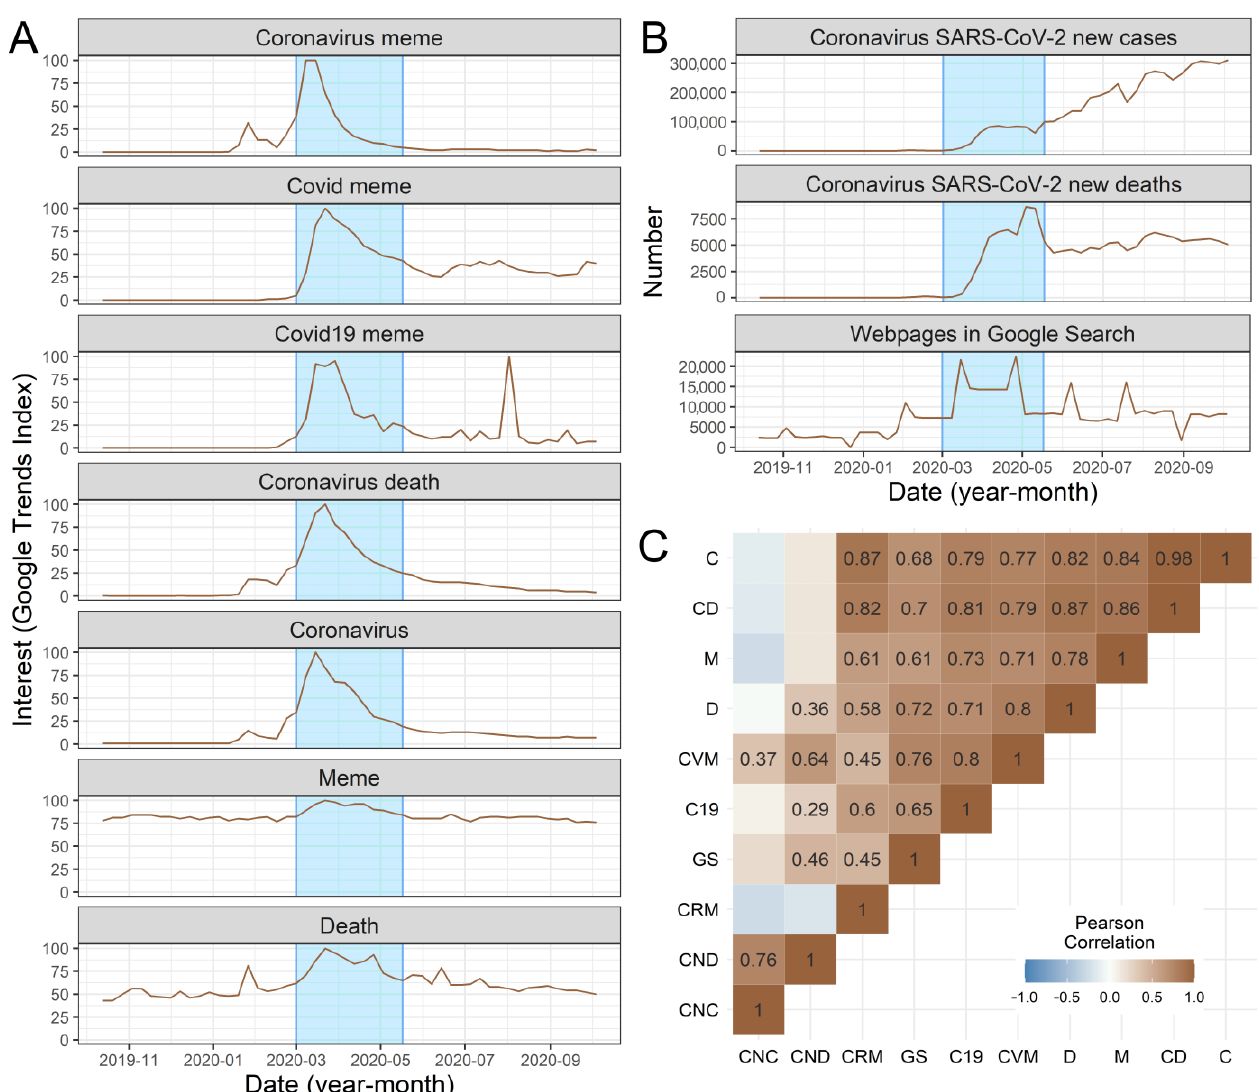
Figure 2. The temporal trends in the selected search strings, coronavirus data, and correlations among analyzed variables. ( A ) The temporal (October 2019 – October 2020) trend in the interest (measured as a Google Trends index) in seven different search strings: “coronavirus meme”, “covid meme”, “covid 19 meme”, “coronavirus death”, “coronavirus”, “meme”, “death”. The blue rectan- gles indicate the period of a spring 2020 lockdown. ( B ) The temporal changes in real numbers of SARS-CoV-2 coronavirus new cases and deaths, and web pages in Google Search containing the phrase: “(coronavirus OR covid 19 OR covid) meme”. ( C ) Correlations among the search strings, real coronavirus data and number of webpages. Only statistically significant associations are shown